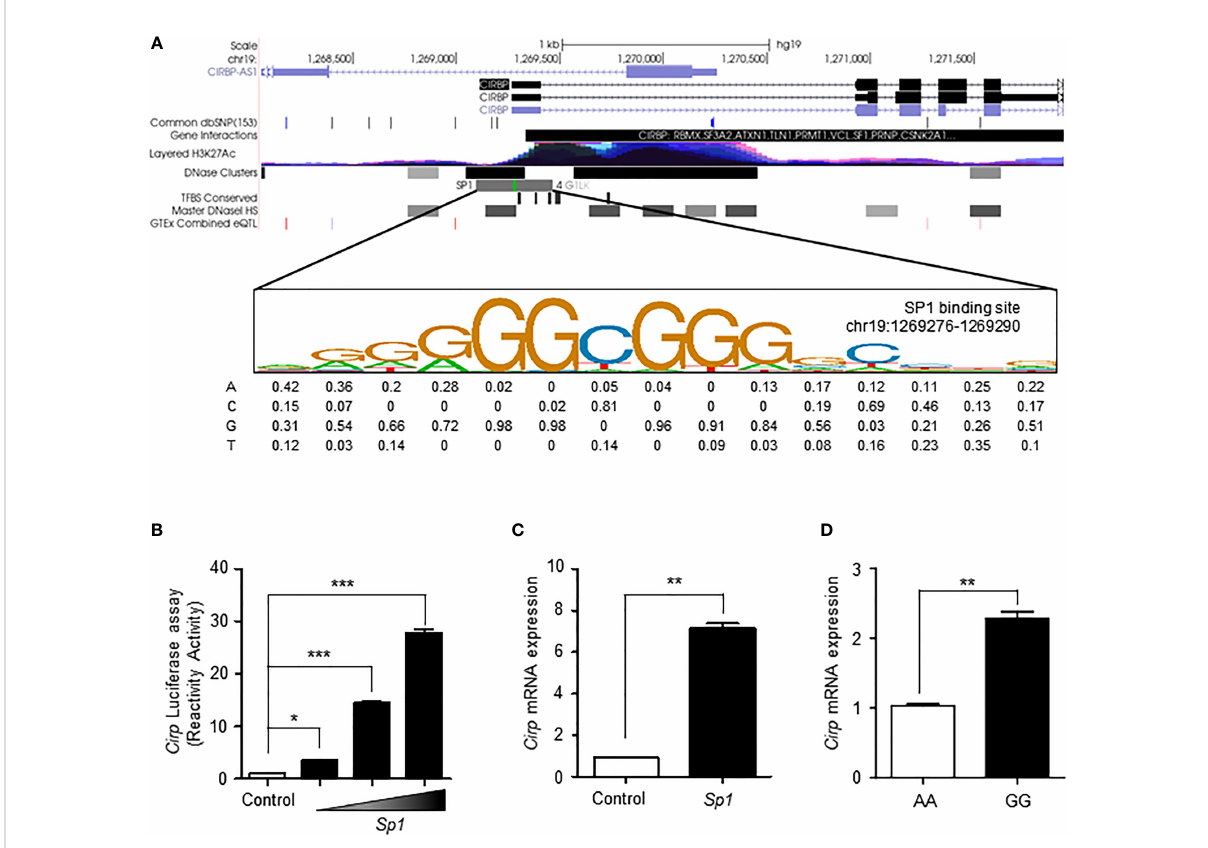
FIGURE 3 SP1 regulates the transcriptional activation of CIRP by rs11170510 and rs58123204. (A) A strong transcription factor cluster appeared in the Cirp transcriptional promoter region. The SP1 transcription factor binding site on the Cirp promoter was located in the region chr19:1269276- 1269290. (B) HEK293 cells were transfected with a Cirp luciferase reporter construct in the presence or absence of plasmid Sp1 (0.1, 0.5, and 1 m g). Cells were subjected to luciferase assays. (C) HEK293 cells were transfected plasmid Sp1 (1 µg) and analyzed using quantitative PCR for Cirp mRNA expression. (D) PBMCs with major A allele or minor G allele of rs11170510 and rs58123204 were subjected to quantitative PCR for Cirp mRNA using its primer (n = 10, major homo AA; n = 10, minor homo GG). Experiments were repeated at least three times. Graphs are indicative of the mean ± SD. *p < 0.05, **p < 0.01 and ***p < 0.001 (two-tailed unpaired Mann –